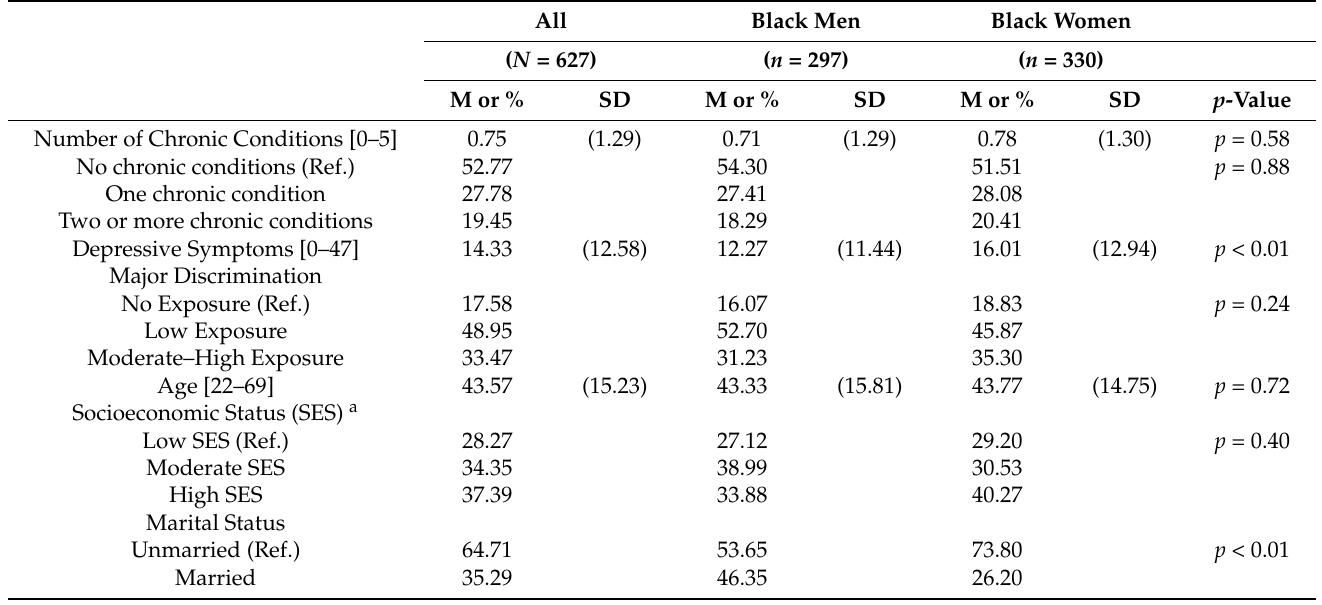
Table 1. Sample Characteristics among Black Men and Women, Nashville Stress and Health Study